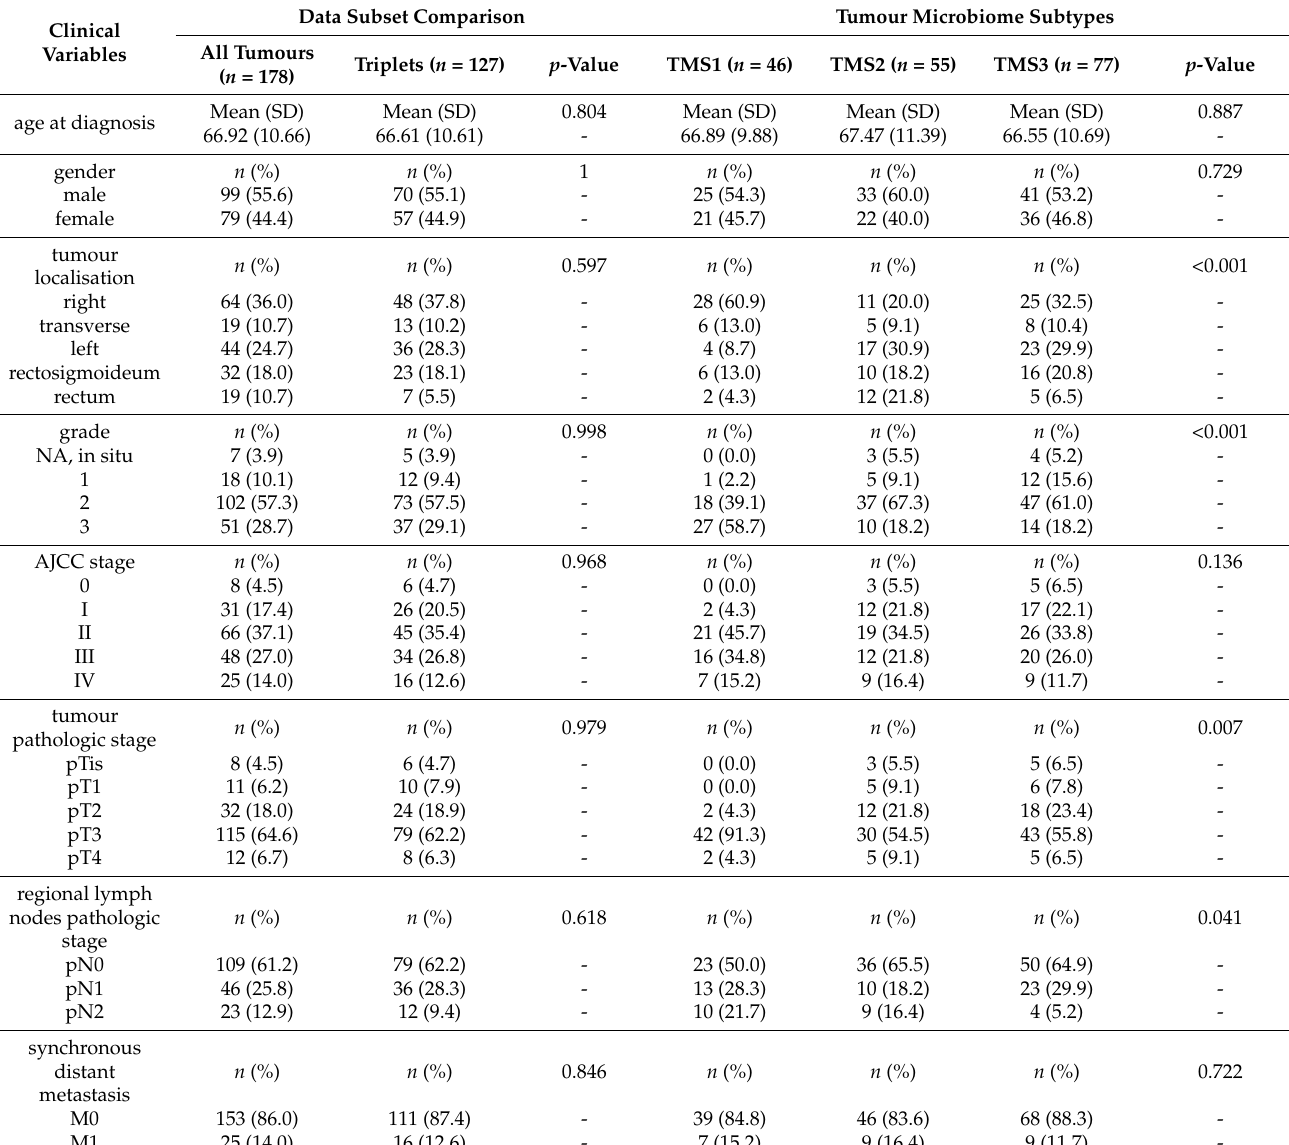
Table 1. Table of clinical variables and their distribution in the complete set of 178 patients, the subset of 127 patients and in the CRC tumour microbial subtypes, respectively. (For categorical variable, Fisher exact test was performed and for continuous data, Kruskal-Wallis test was